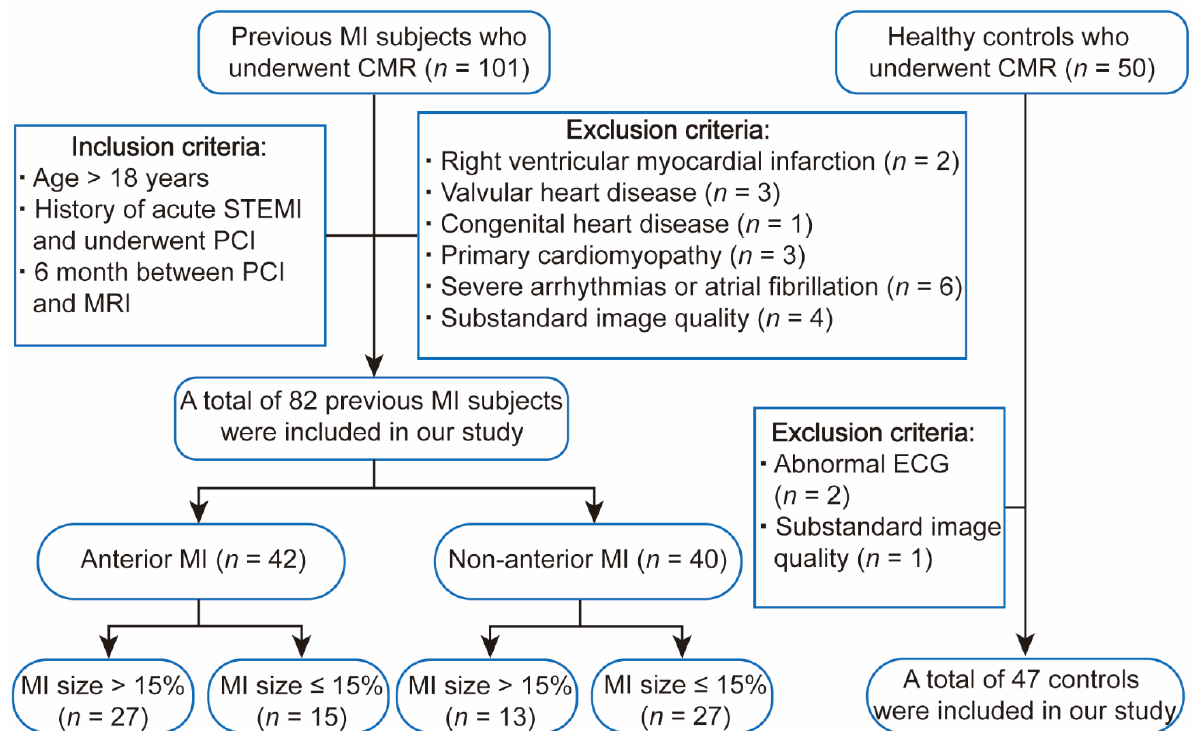
Figure 1. Subject flowchart. MI = myocardial infarction, CMR = cardiac magnetic resonance, ECG = electrocardiogram, STEMI = ST-segment elevation myocardial infarction, PCI = percutaneous coronary intervention.